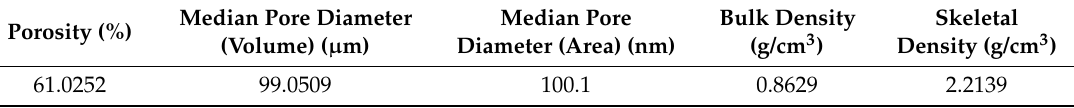
Table 2. The pore parameters of the BioSiC determined by